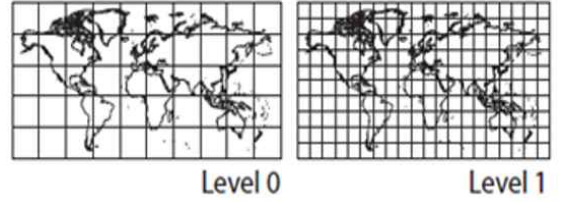
Figure 6. Concept for tile level division